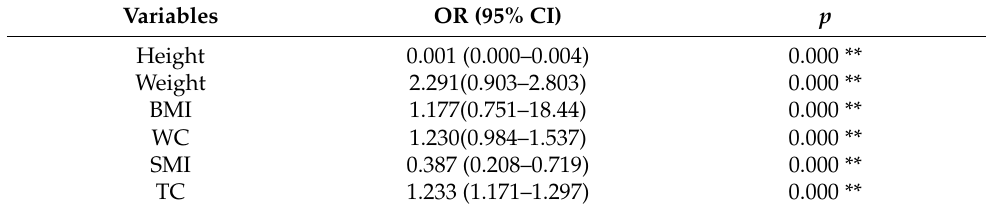
Table 6. Odds ratio for sarcopenia in